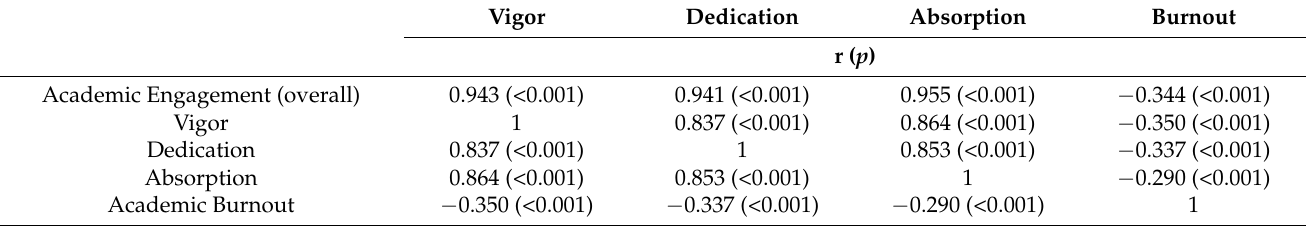
Table 3. Convergent validity of relationships in the KUWES-S with academic burnout ( N = 248).